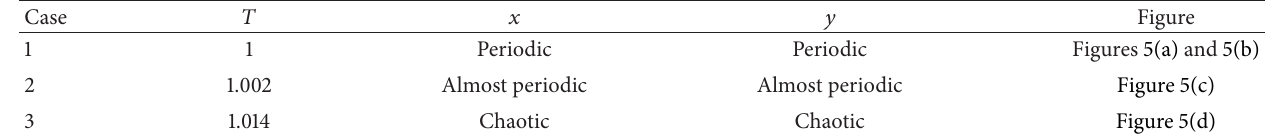
Table 5: The effects of impulse period 𝑇 on the dynamical behavior of system (3).